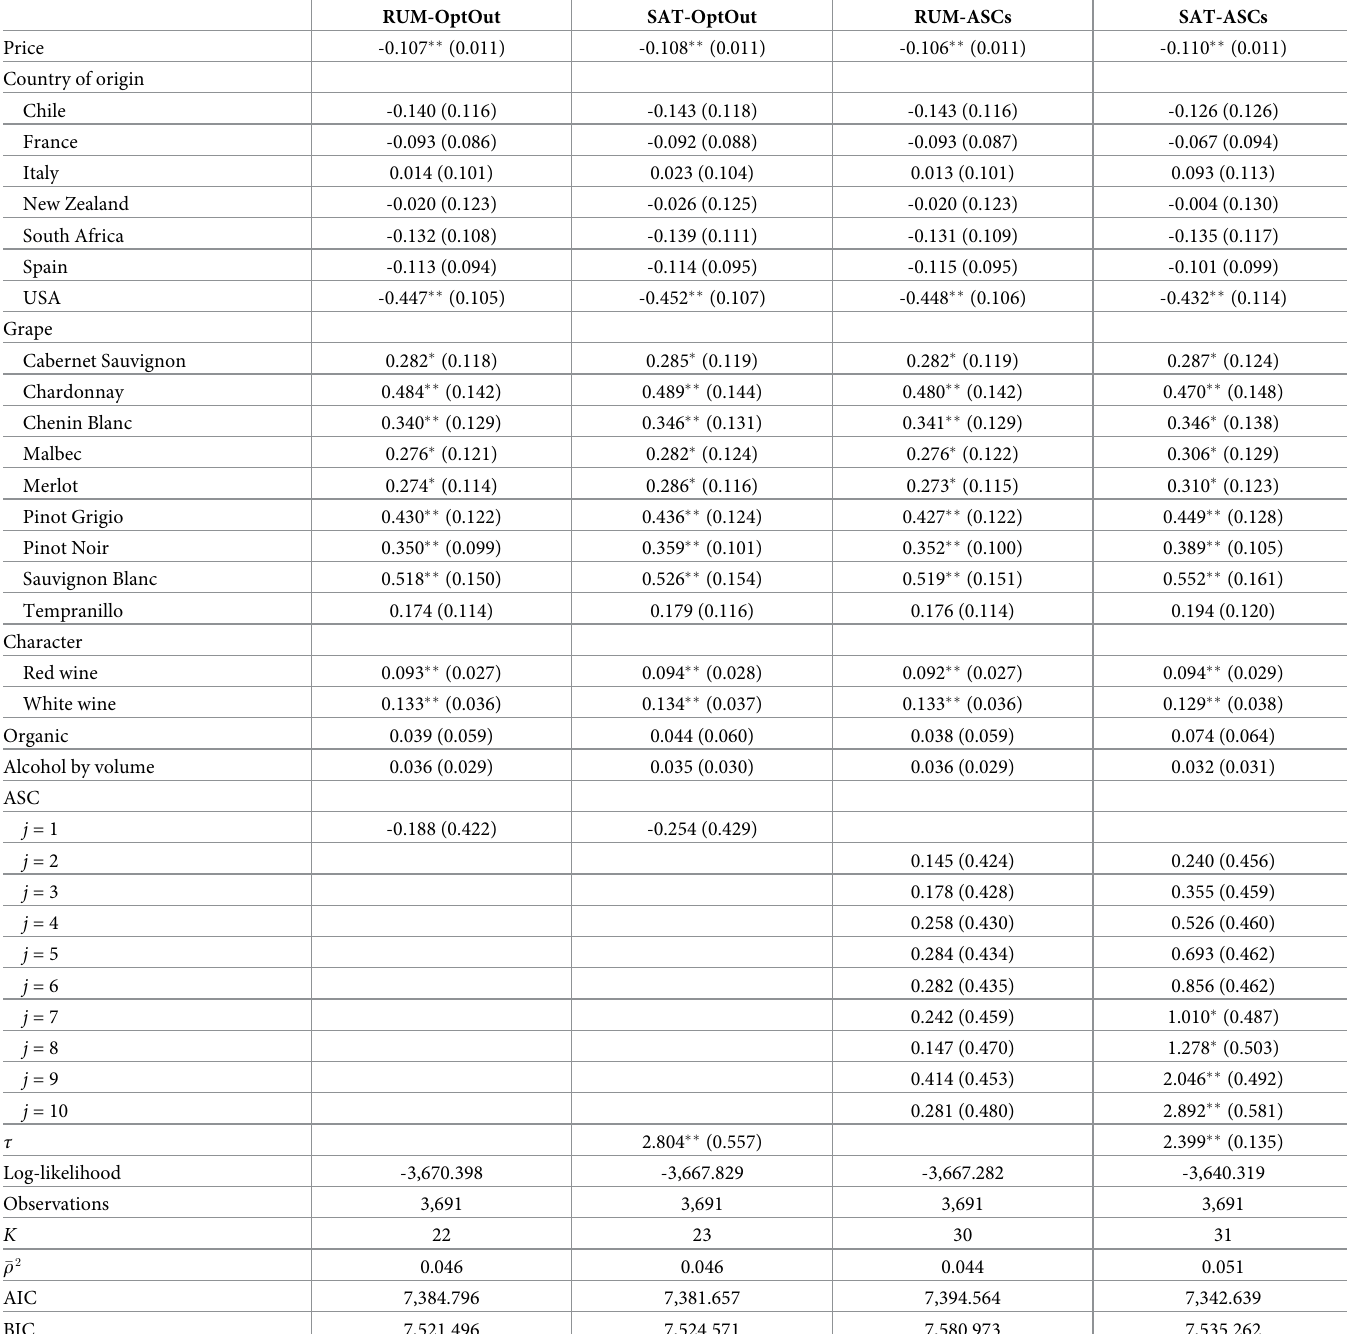
Table 7. Estimation results for treatment